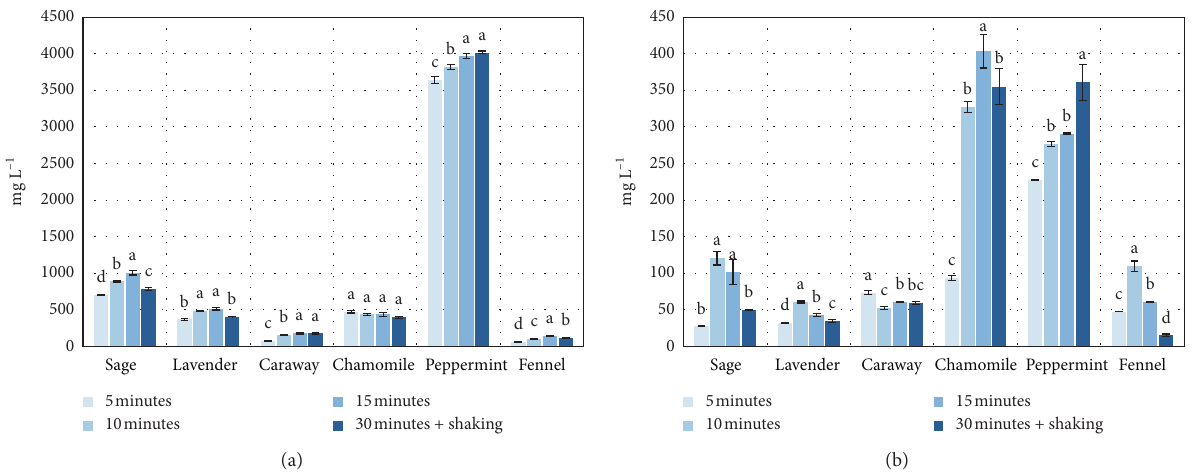
Figure 2: Concentration of polyphenols expressed in gallic acid equivalents (a) and flavonoids expressed in quercetin equivalents (b) in primary herbal brews (mg · L − 1 ). Data are shown as mean ± SD. Different letters (a, b, c, etc.) show a significant difference with p < 0 .